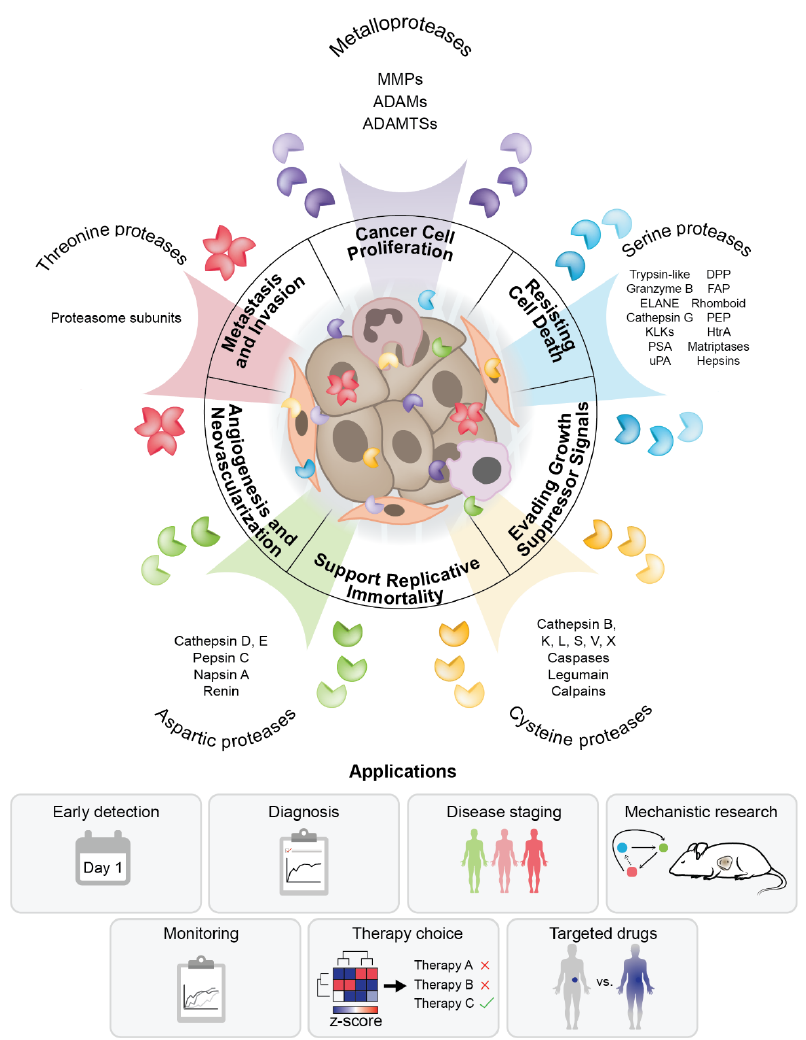
Figure 1. Knowledge of tumor proteolysis translates into diagnostic and therapeutic modalities. Proteases in the tumor microenvironment belong to different protease families and originate from tumor and other cells present in the tumor microenvironment. They exhibit different patterns of localization and activity that may overlap and generate an intricate proteolytic landscape with roles in mechanisms behind cancer hallmarks. Knowledge of the role of proteolysis in cancer can support diagnosis, staging, mechanistic studies, disease monitoring and